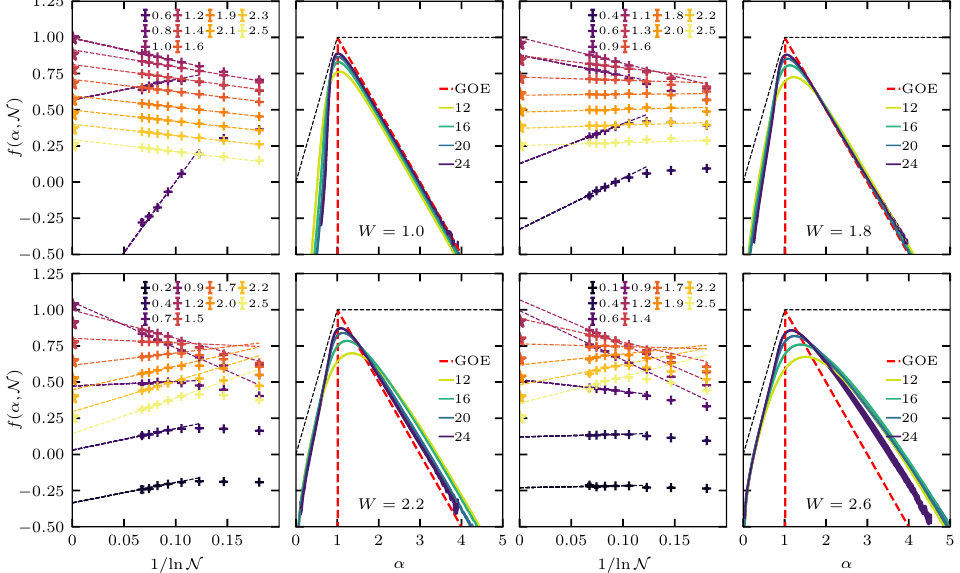
Figure 6: Odd columns . f ( α , N ) vs 1 / ln N for different α values (see leg- end). Dashed colored lines correspond to an extrapolation to N → ∞ , and the stars on the y-axis correspond to the infinite size GOE prediction. Even columns . The finite size multifractal spectrum, f ( α , N ) calculated using Eq. (15) for L = 12,16,20,24 (darker colors, correspond to larger system sizes) and disorder strengths W = 1.0,1.8,2.2,2.6, the width of the lines correspond to statistical errors. ( α ) according Red dashed line corresponds to the infinite size GOE prediction, f GOE to (14), and black dashed lines show the upper bounds on f ( α ) according to (13). The error bars are represented by filled areas of the order of the line